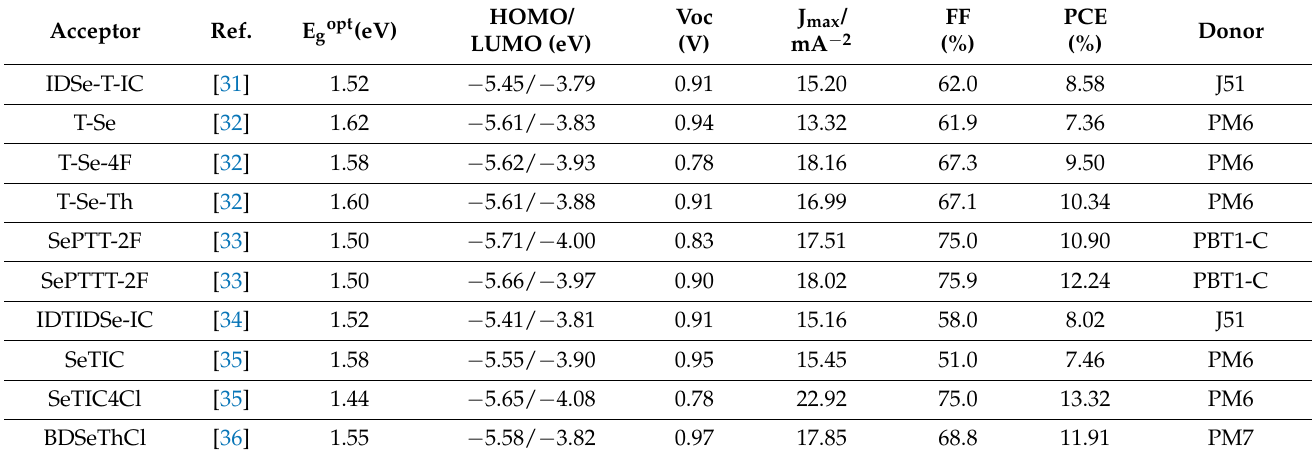
Figure 3. Selenophene small molecule acceptors. Table 1. Device parameters for selenophene-substituted acceptors